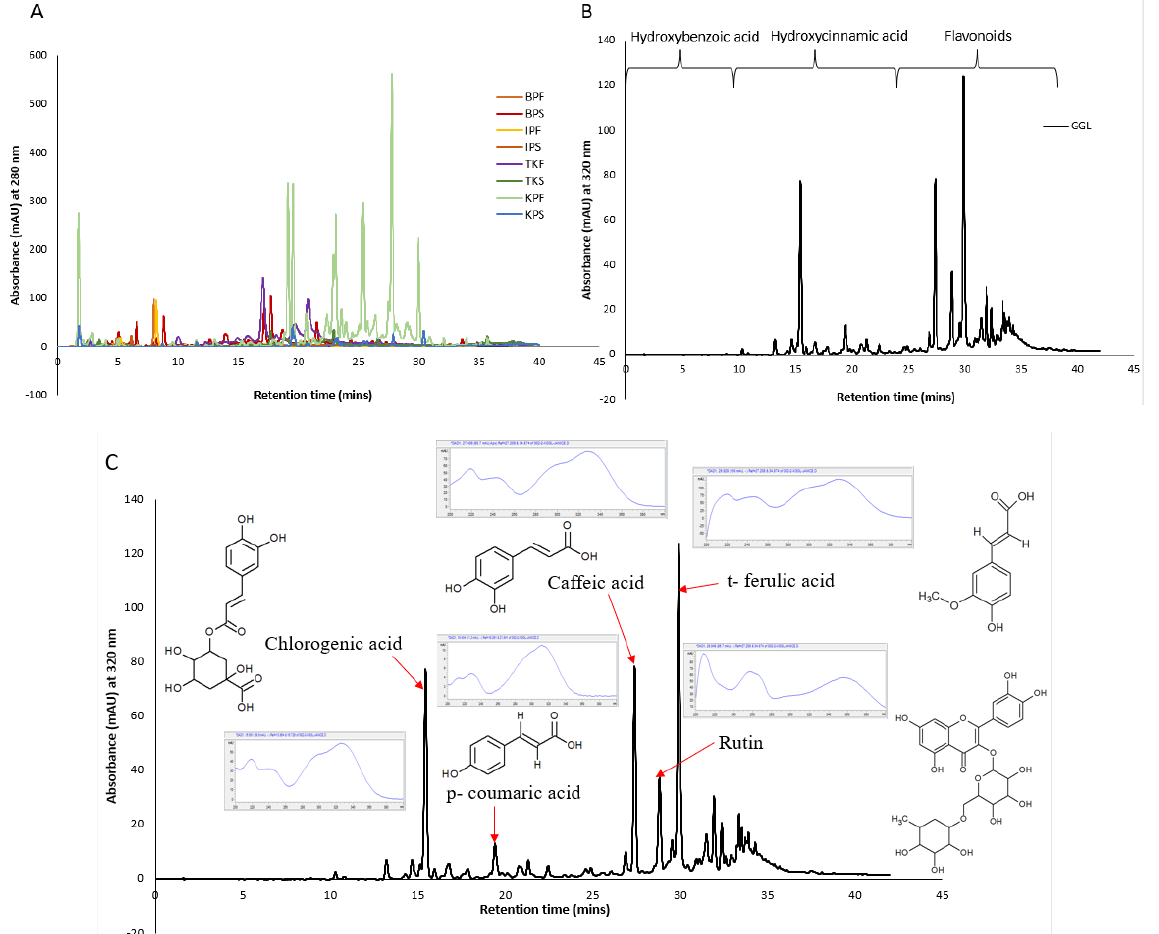
Figure 7. HPLC phenolic profile of the fruits ( A ) and GGL ( B ) methanolic extracts. Tentative peak identification of GGL extracts ( C ).